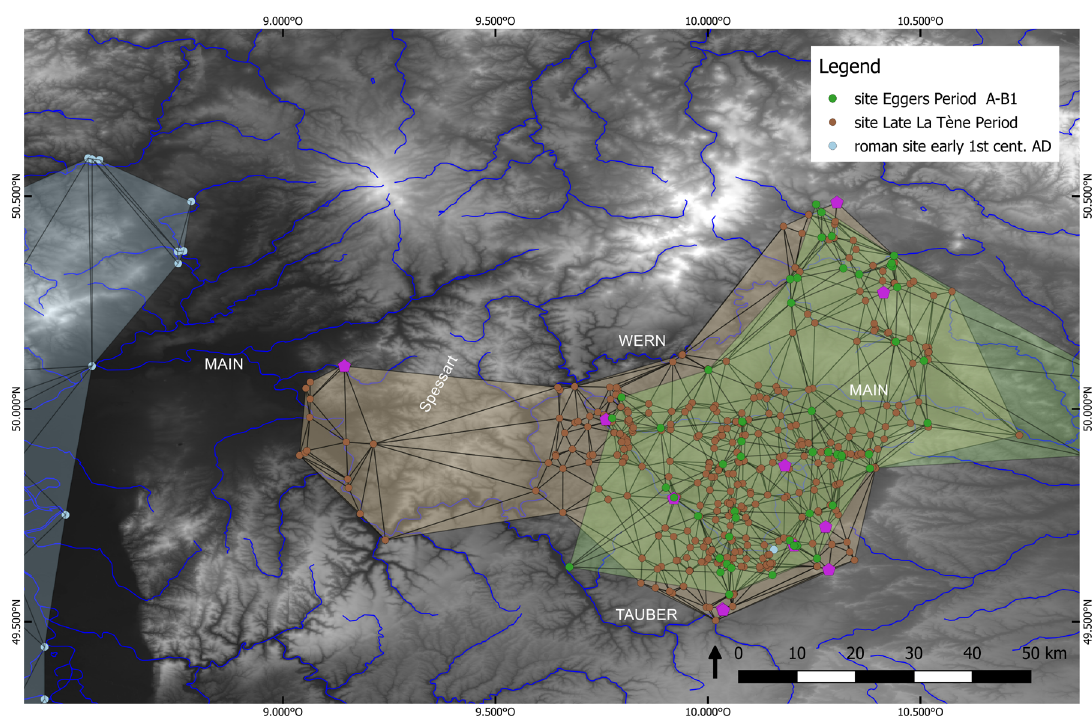
Figure 3. Late La Tène Period sites from the Late Iron Age in the late 1st century BC (approximately 85 to 15 BC) are in brown. Compare with sites dating to the Early Roman Iron Age I (Eggers Period A-B1, 15 BC to 70 AD) in green. Also depicted are Late La Tène hilltop settlements (purple pentagons) whose use did not continue into the earliest Roman Iron Age. In